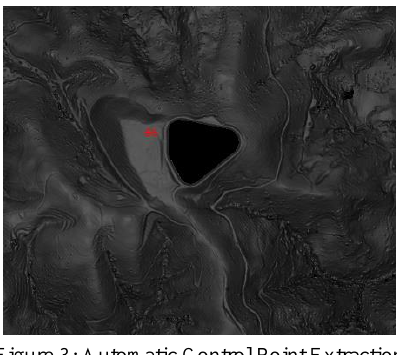
Figure 3: Automatic Control Point Extraction